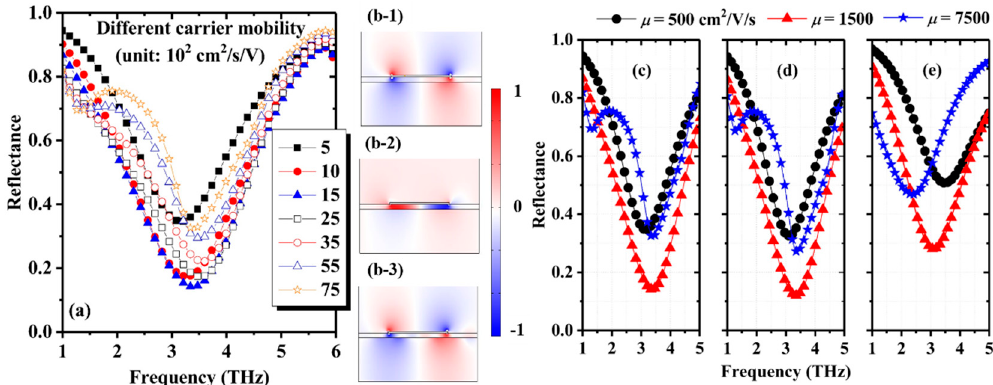
Figure 4. Reflection spectra and field distributions for different carrier mobilities and the fixed carrier concentration of n = 7×10 12 /cm 2 . ( a ) FEM (COMSOL) numerical reflection spectra and the corresponding field distributions ( b ) for μ = 1500 cm 2 /s/V at 3.35 THz ( b-1 ), μ = 7500 cm 2 /s/V at 1.4 THz ( b-2 ), and μ = 7500 cm 2 /s/V at 3.35 THz ( b-3 ), respectively, and ( c ) reflection spectra calculated with FEM ( c ), MM ( d ), and ECM ( e ) for carrier mobilities of μ = 500, 1500, and 7500 cm 2 /s/V, respectively.